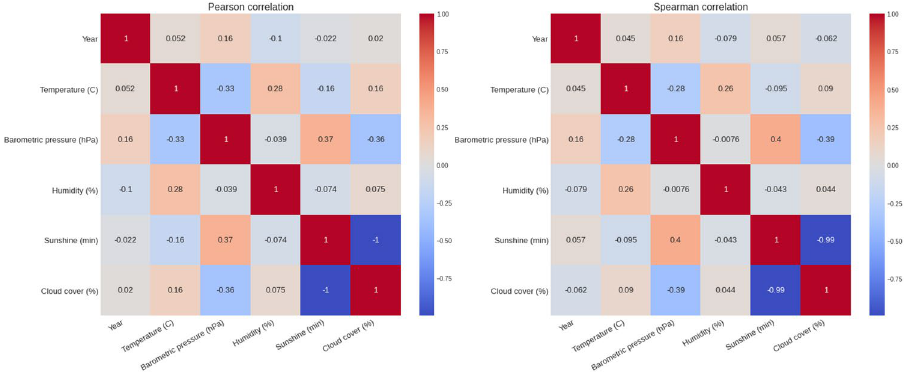
Figure 2. Correlation matrixes for weather variables and calendar years.